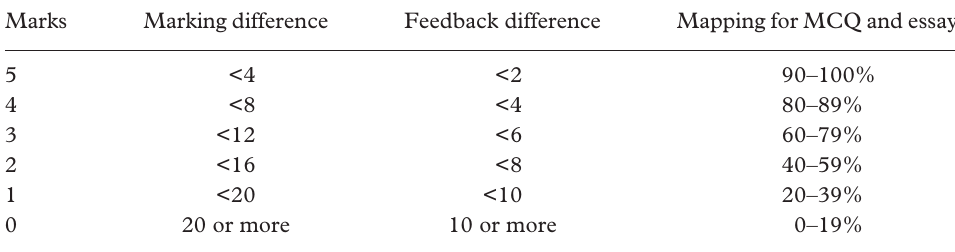
Table 5. Mapping to common assessment scale 0–5